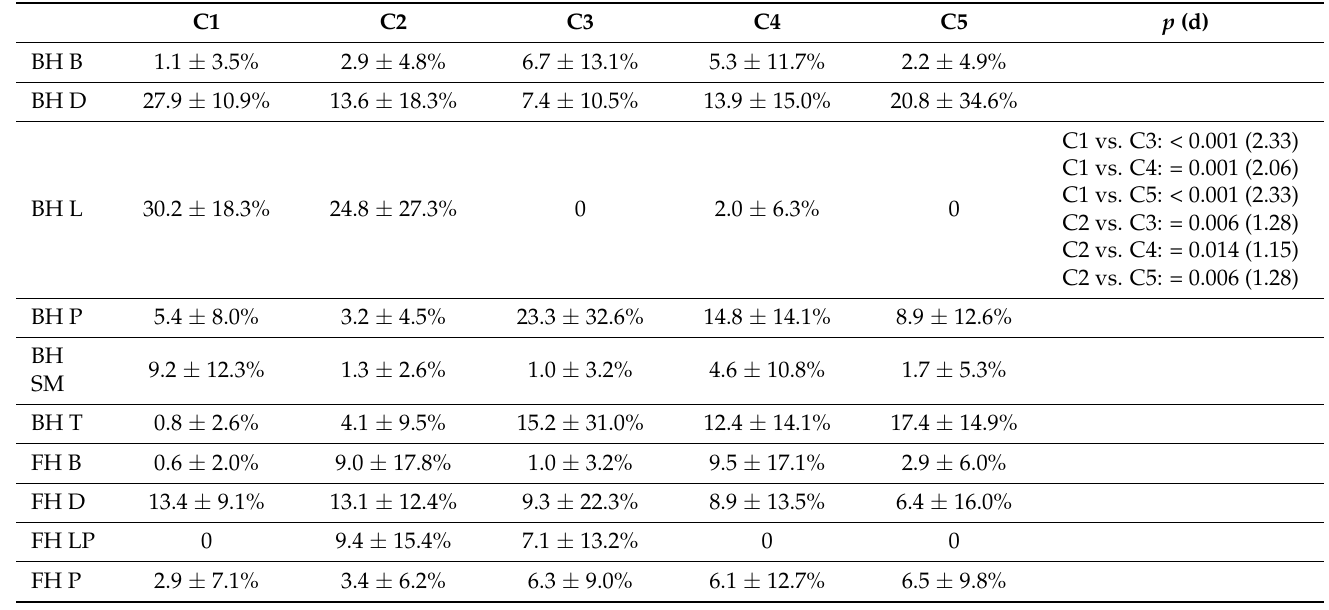
Table 10. Distribution of strokes type in winner outcome for each class (mean ±